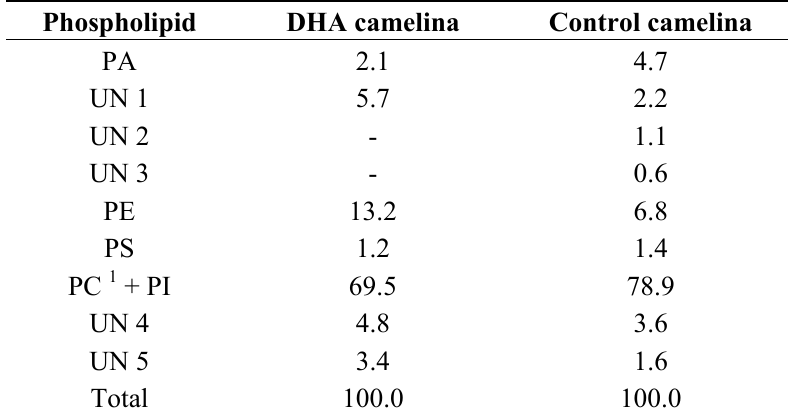
Table 3. Phospholipid composition (% of total phospholipids) of CM extracts from DHA- and control camelina